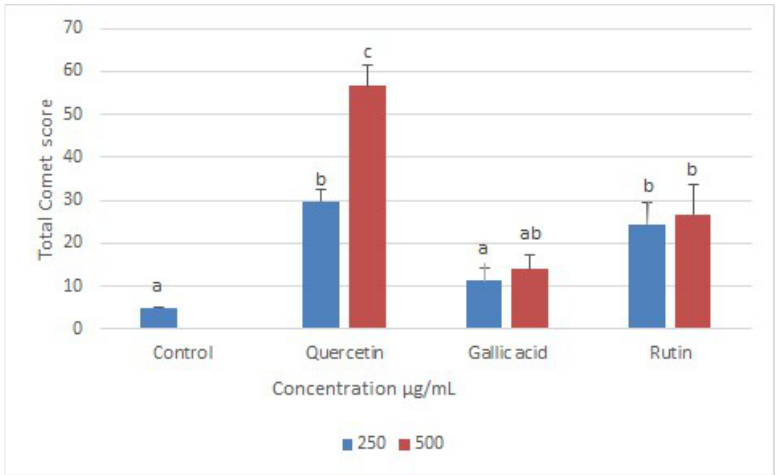
Figure 8. Total comet scores of leishmanial DNA damage following treatment with quercetin, gallic acid, and rutin, compared with control DNA (from untreated Leishmania). Data represent the mean values of three replicates with ± standard error. Different labels on columns show significant difference at p < 0.05.